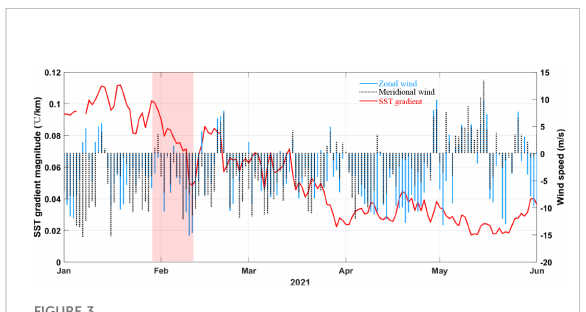
FIGURE 3 The spatially-averaged SST gradient magnitude of the focus region (Figure 1B) is shown in the red line, while the speed of zonal and meridional wind from ERA5 is in the blue line and black-dots-line (eastward and northward positive), respectively. The red shaded region marks off the sudden decrease of the SST